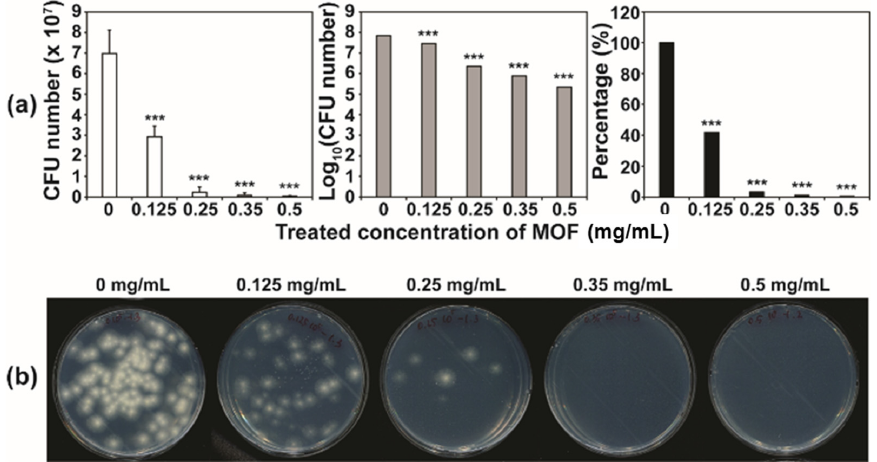
Figure 4. Antifungal activities of Cu(AZPY)-MOF against A. niger . ( a ) Fungal spore viability indi- cated as the CFU number, Log 10 (CFU number), and relative percentage after 1 day of treatment with Cu-MOF . Each germinated spore was considered a CFU. Each value in CFU number was an average of nine replicate measurements. Log10 (CFU number) and relative percentage were calculated using the average value of CFU number. *** p < 0.01. ( b ) Pictures of plates showing CFU. The cell suspen- sion was diluted 10 5 times after the treatment with Cu(AZPY)-MOF and 100 μ L was spread onto the plates.